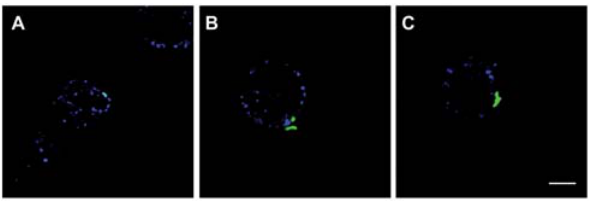
Figure 5. H37Rv associates weakly with plasma membrane domains enriched in GM1 gangliosides. H37Rv expressing GFP (green fluorescence) were allowed to adhere to MDMs for 30 minutes at 4 u C. Cells were then stained with Alexa-647 CTB (blue fluorescence) and processed for analysis by confocal microscopy. Representative single optical x-y planes from confocal microscopy images are shown. (A) Colocalization of GFP-H37Rv and Alexa-647 CTB at the plasma membrane gives a turquoise signal. (B–C) Two examples of an absence of colocalization between GFP-H37Rv and Alexa-647 CTB at the plasma membrane. The data presented are from a single experiment representative of two. Bar: 12 m m.